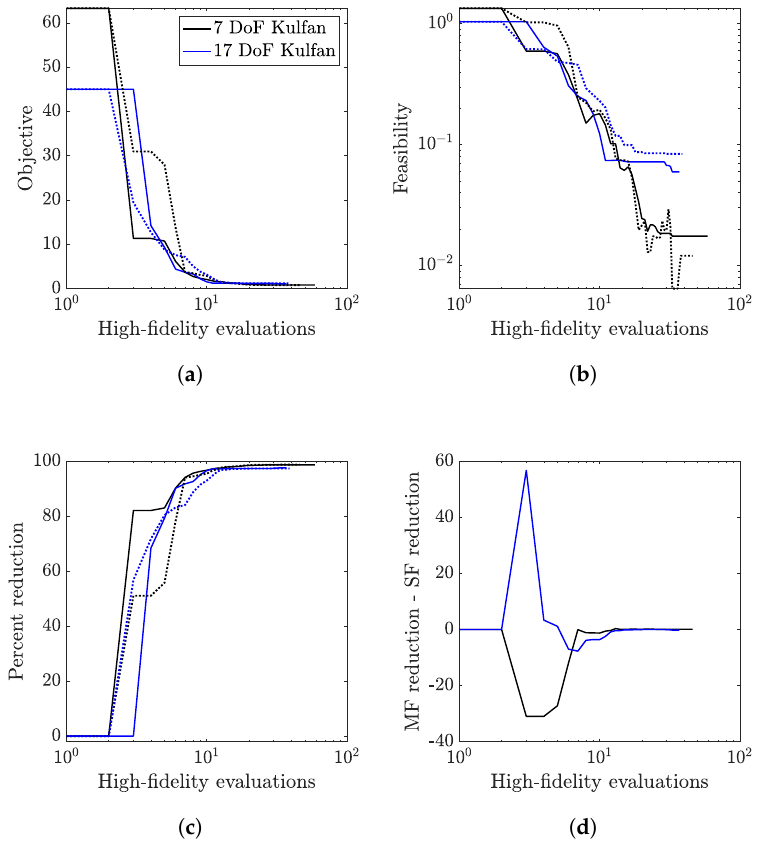
Figure 13. Optimization results for structural sizing cases, variable airfoils. ( a ) Penalty-constrained objective; ( b ) Feasibility; ( c ) Percent reduction, all; ( d ) Percent reduction,